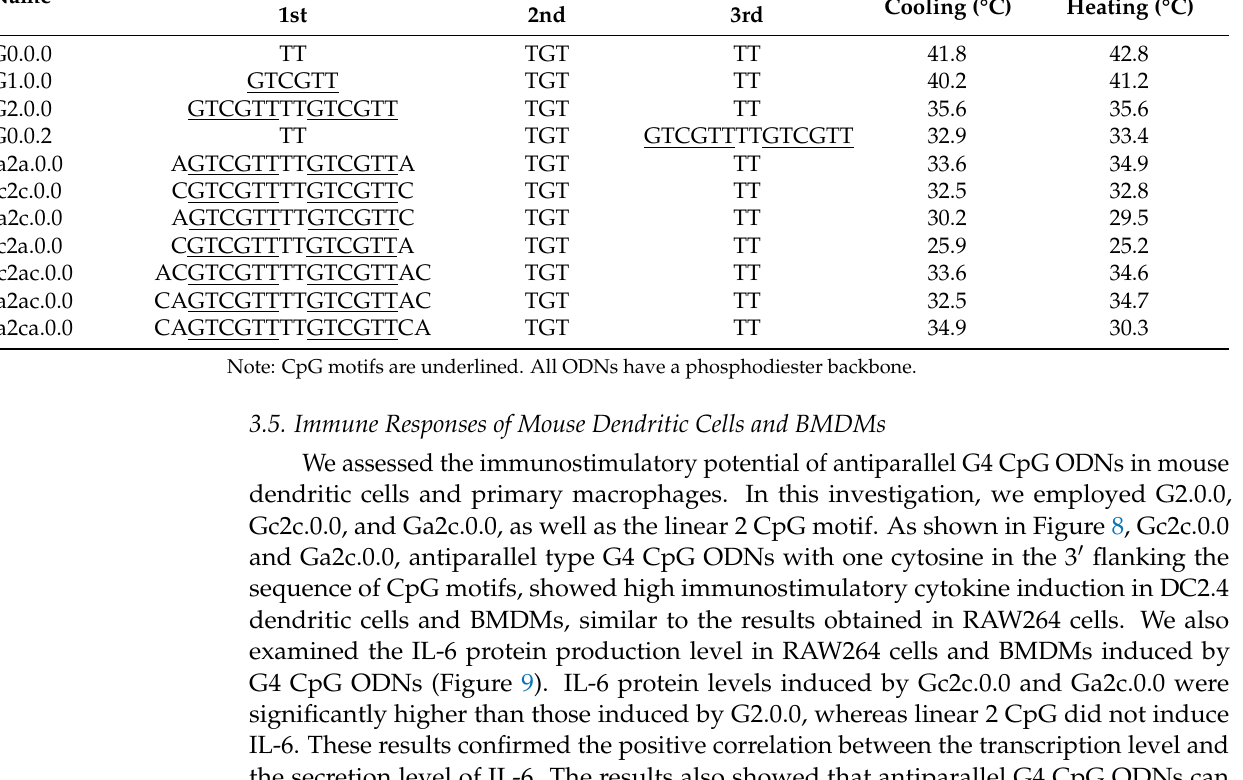
Table 2. Melting temperature at the first cooling and second heating of antiparallel ODNs with CpG motif substitutions in the first functional loop, with or without additional connectors, obtained from CD ‐ melting curves in D ‐ PBS.